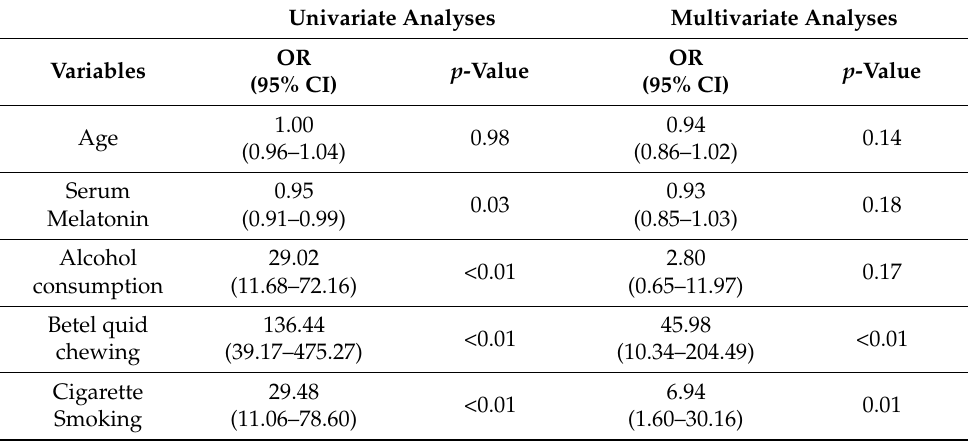
Table 3. Risk factors for OSCC patients in Taiwan. Univariate Analyses Multivariate